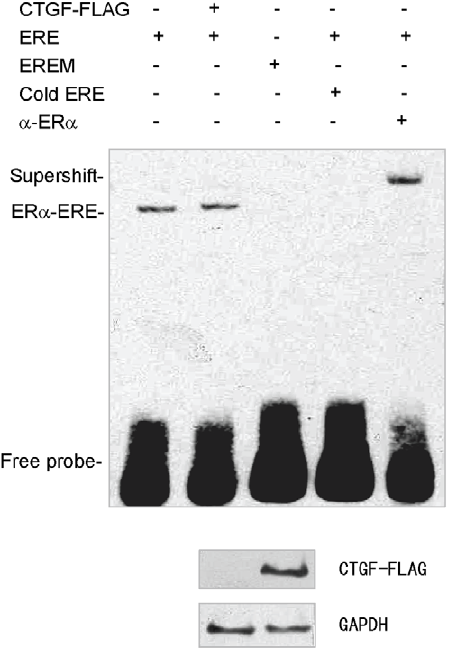
Figure 7. Effect of CTGF on ER a binding to ERE sequence. EMSA was performed using biotin-labeled ERE probe and nuclear proteins extracted from ZR75-1 cells transfected with empty vector or FLAG- tagged CTGF in the presence of 10 nM E2. For competition experiments, a 100-fold molar excess of unlabeled ERE was incubated with the labeled probe. The biotin-labeled mutant ERE probe (EREM) was used as a negative control. Supershifts were performed using specific anti-ER a antibody. The representative immunoblot with anti- FLAG shows the expression level of intracellular FLAG-tagged CTGF (lower